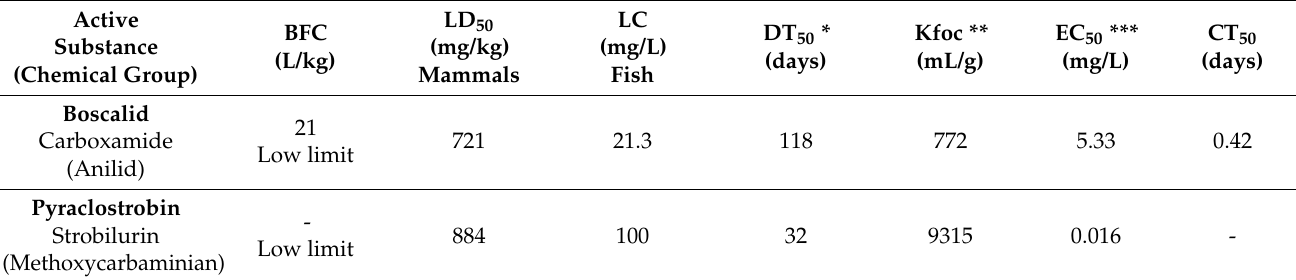
Table 3. Toxicological parameters of boscalid and pyraclostrobin.